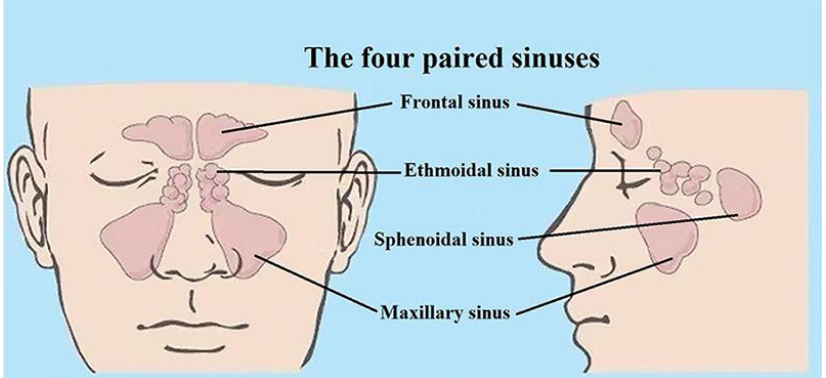
Figure 1. The anatomic locations of the human sinuses. A frontal and a coronal view are shown with the four paired sinuses. Anatomy figure adapted from [9].